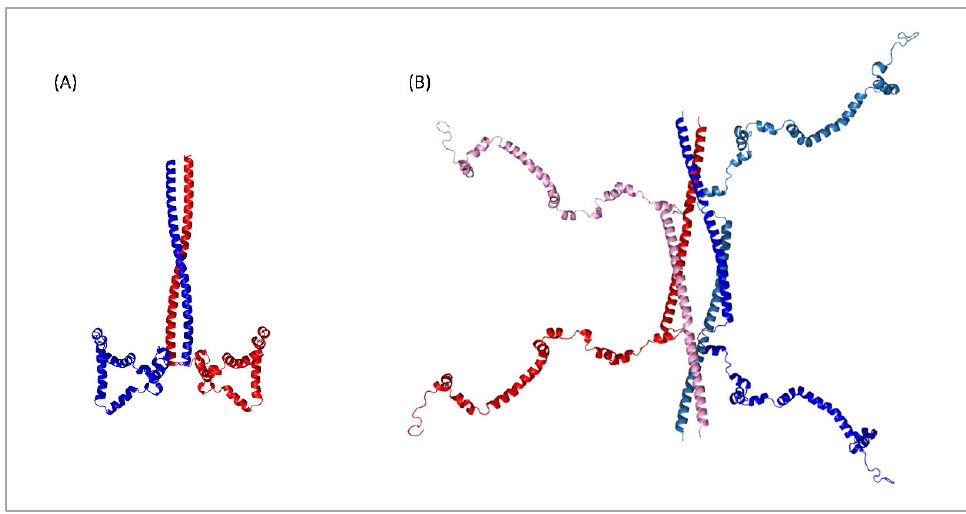
Figure 6. Structural models of cl-Par-4. ( A ) Dimer form, consistent with acidic pH data. Model generated using GalaxyTBM on the GalaxyWEB server using rat Par-4 CC domain crystal structure (pdb 5fiy_A) as a template and allowing the remainder of the protein to fold computationally [37,48,49]; ( B ) Tetramer form, consistent with high salt data. Model generated using GALAXYWEB HOMOMER on the GalaxyWEB server using pdb 5DOL (YabA) as a template for the four central helices and allowing the remainder of the protein to fold computationally [38,48,50]. Each color represents a distinct monomer.